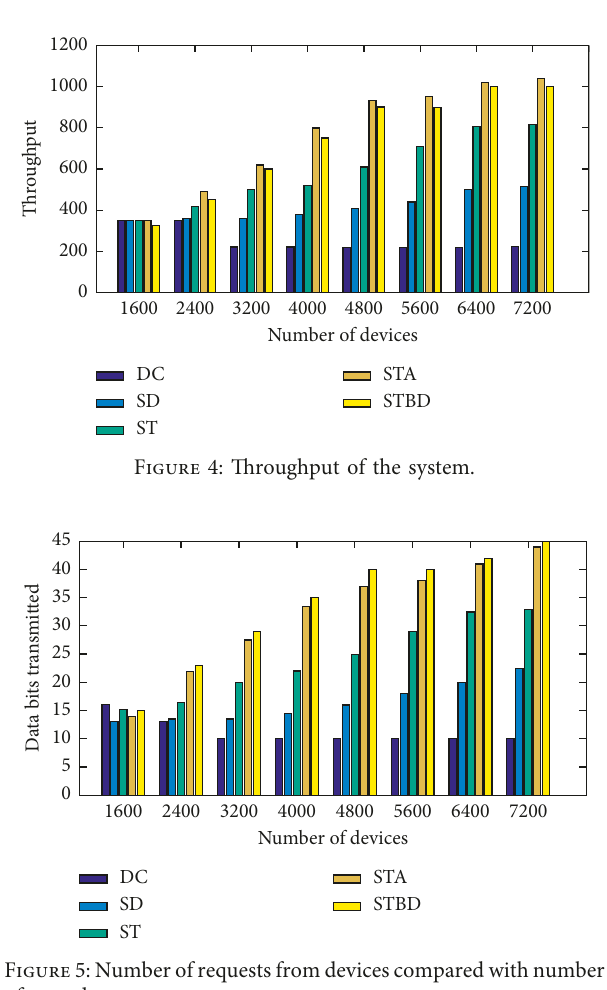
Figure 6: Number of requests from devices compared with number of RBs allocated per second.